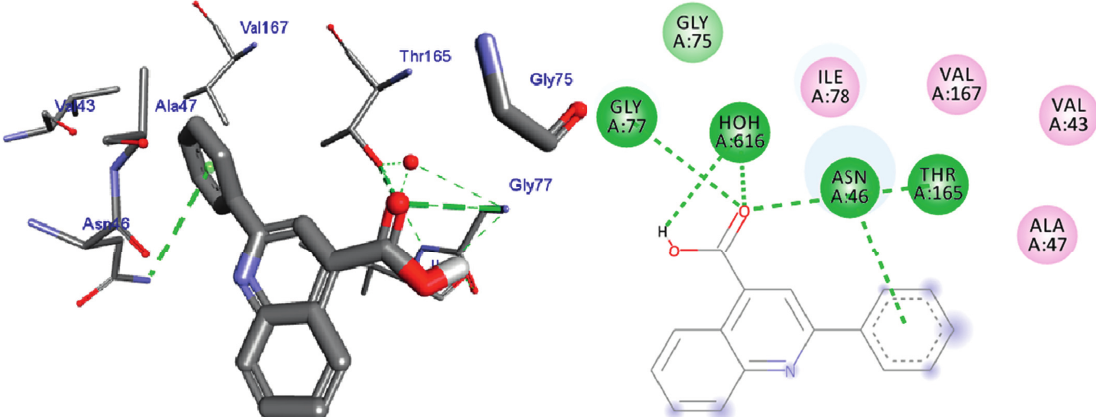
Figure 7: The binding interactions of 12 against E. coli DNA gyrase A (PDB ID: 6F86).